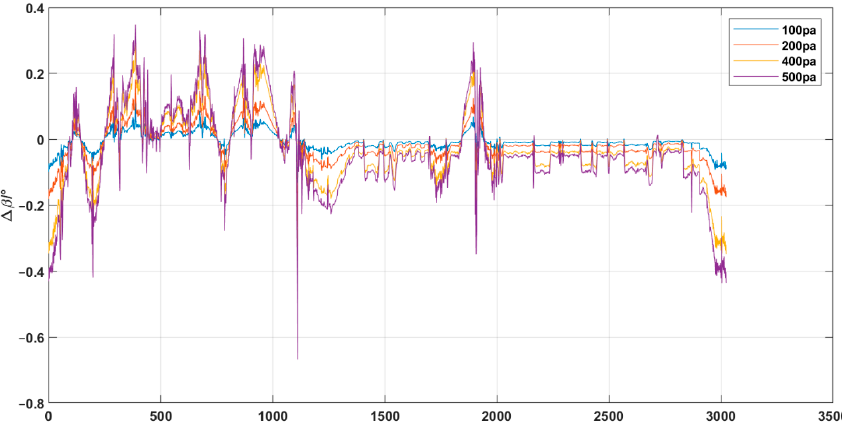
Figure 12. Prediction results of the angle of attack with fault pressure combinations.